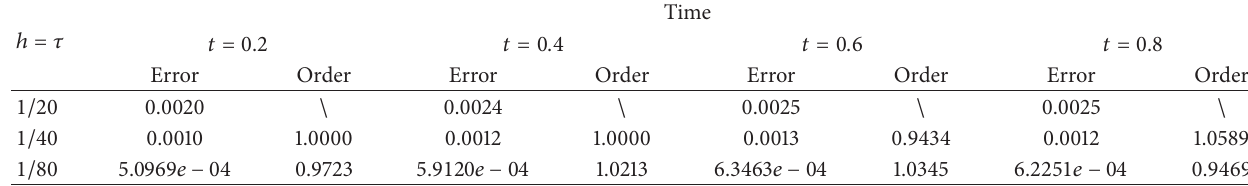
Table 2: The errors of ‖𝑢 𝐽 𝑥 − 𝑈 𝐽 𝑥 ‖ at different time.